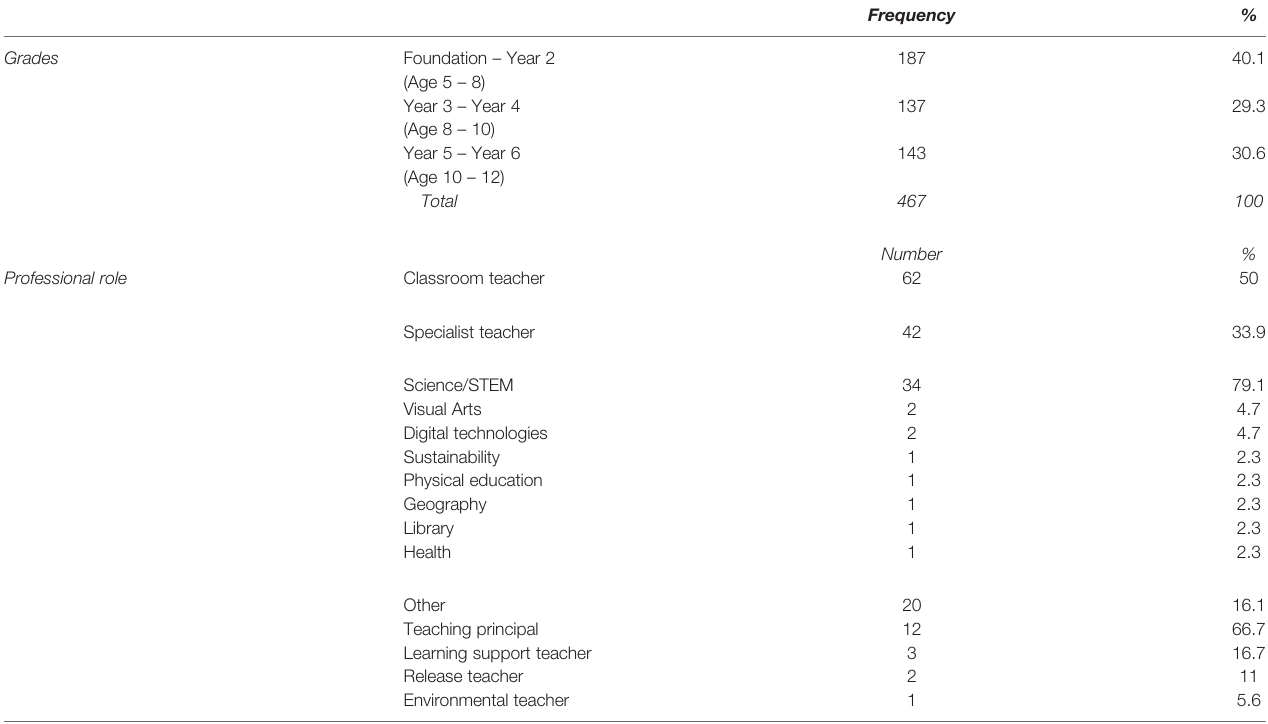
TABLE 1 | Survey demographics (N=124